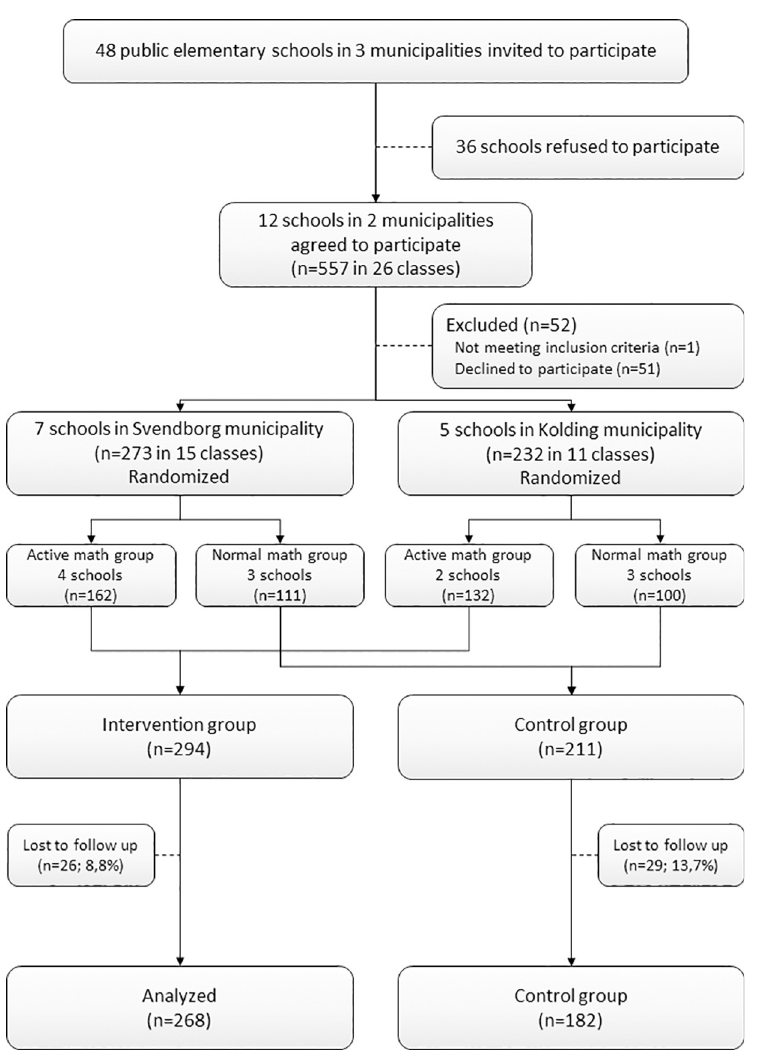
Fig 1. Flowchart of the recruitment and randomization